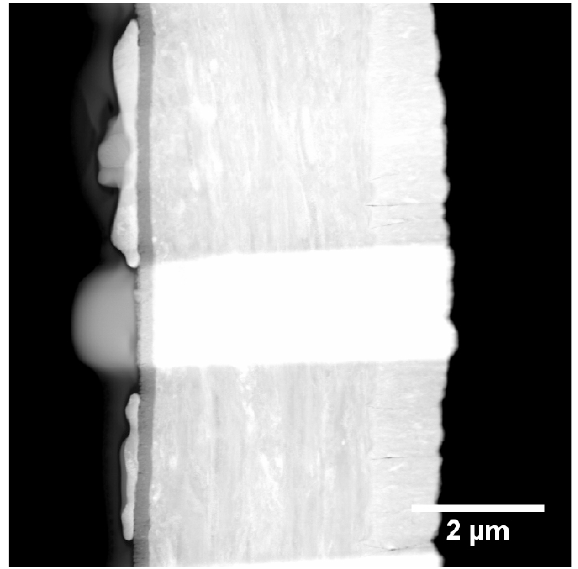
Figure 19. STEM HAADF overview image of sample “Ru/Ti-3”. The FIB preparation was performed in two regions with differently shaped catalyst particles.